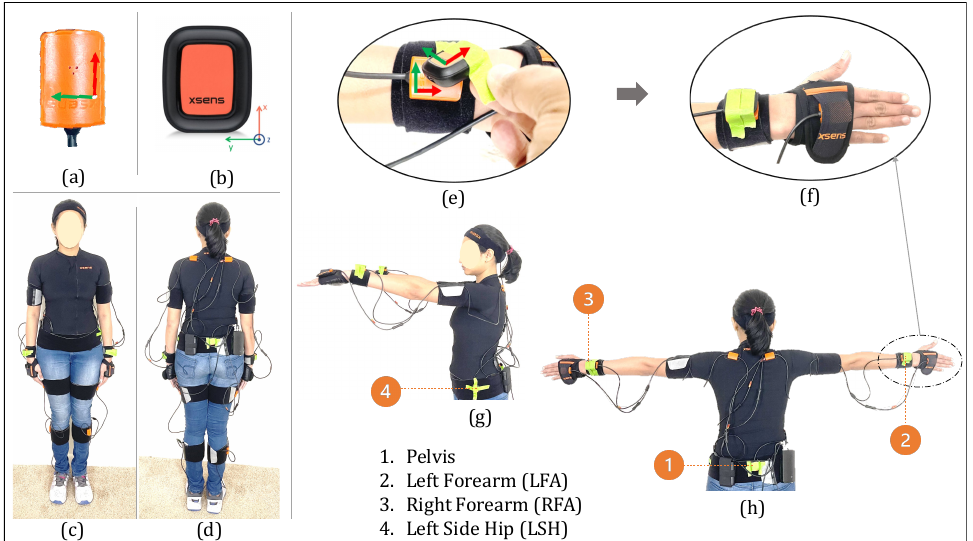
(d) Figure 8. The data collection process using XSens MVN and XSens DOT sensors. In ( a , b ), we show the local coordinate system of the XSens MVN sensor and DOT sensors, respectively. In ( c , d ), we present front and back views of a participant wearing both sensor systems. In ( e – h ) we show detail of the locations of the XSens DOT